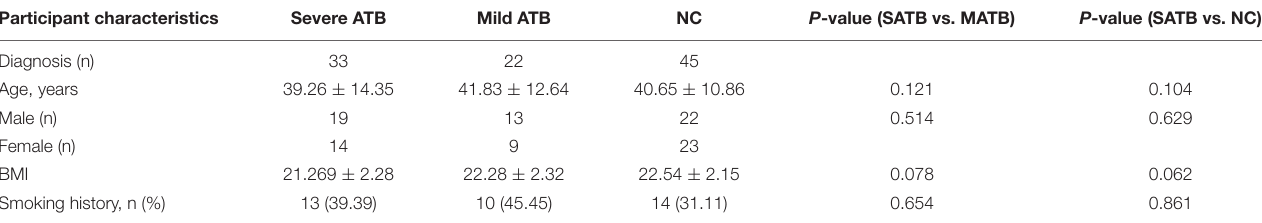
TABLE 1 | Characteristics of patients with ATB and NC